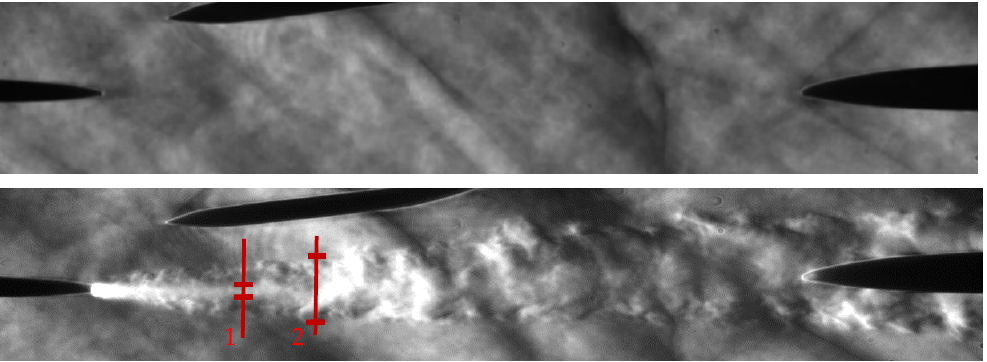
Figure 5. Typical schlieren images of the supersonic flow field ( top ) without discharge and ( bottom ) with discharge. 1 — Discharge channel, 2 — heated cone.